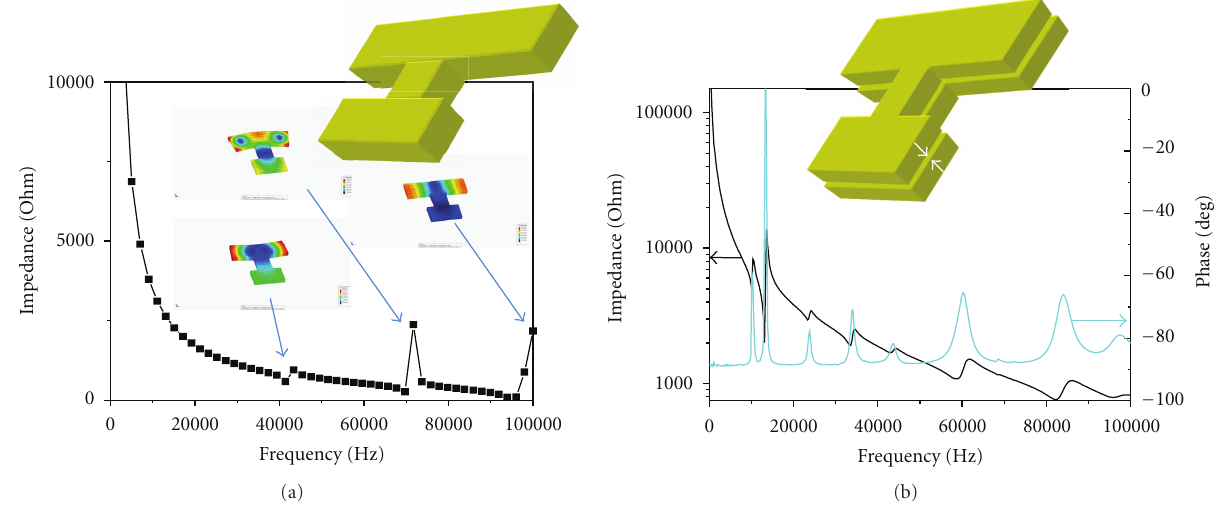
Figure 11: Resonance analysis: (a) unimorph and (b) bimorph piezoelectric asymmetric H-shaped structure [12].